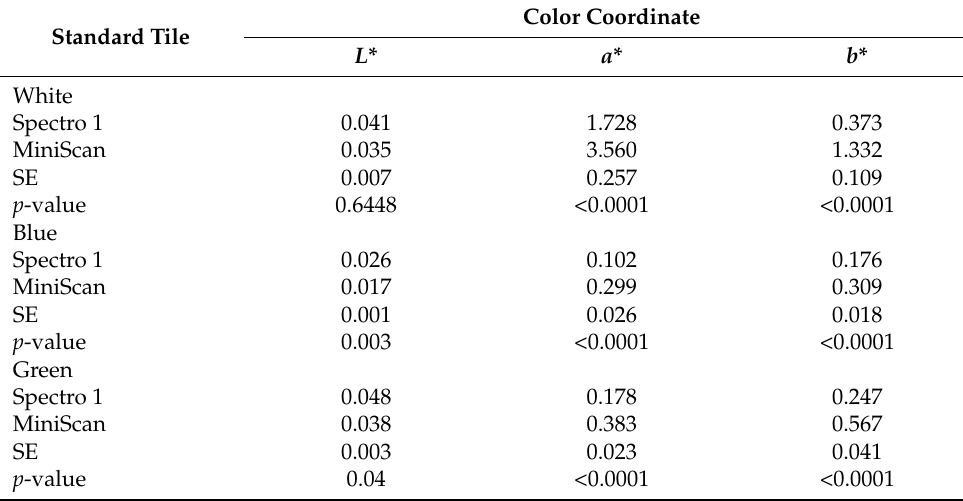
Table 2. Coefficient of variation (CV) for lightness ( L *), redness ( a *), and yellowness ( b *) obtained from white, blue, and green calibration tiles over a 60-min period using Spectro 1 and MiniScan ( n = 12). Data are least-squares mean ±